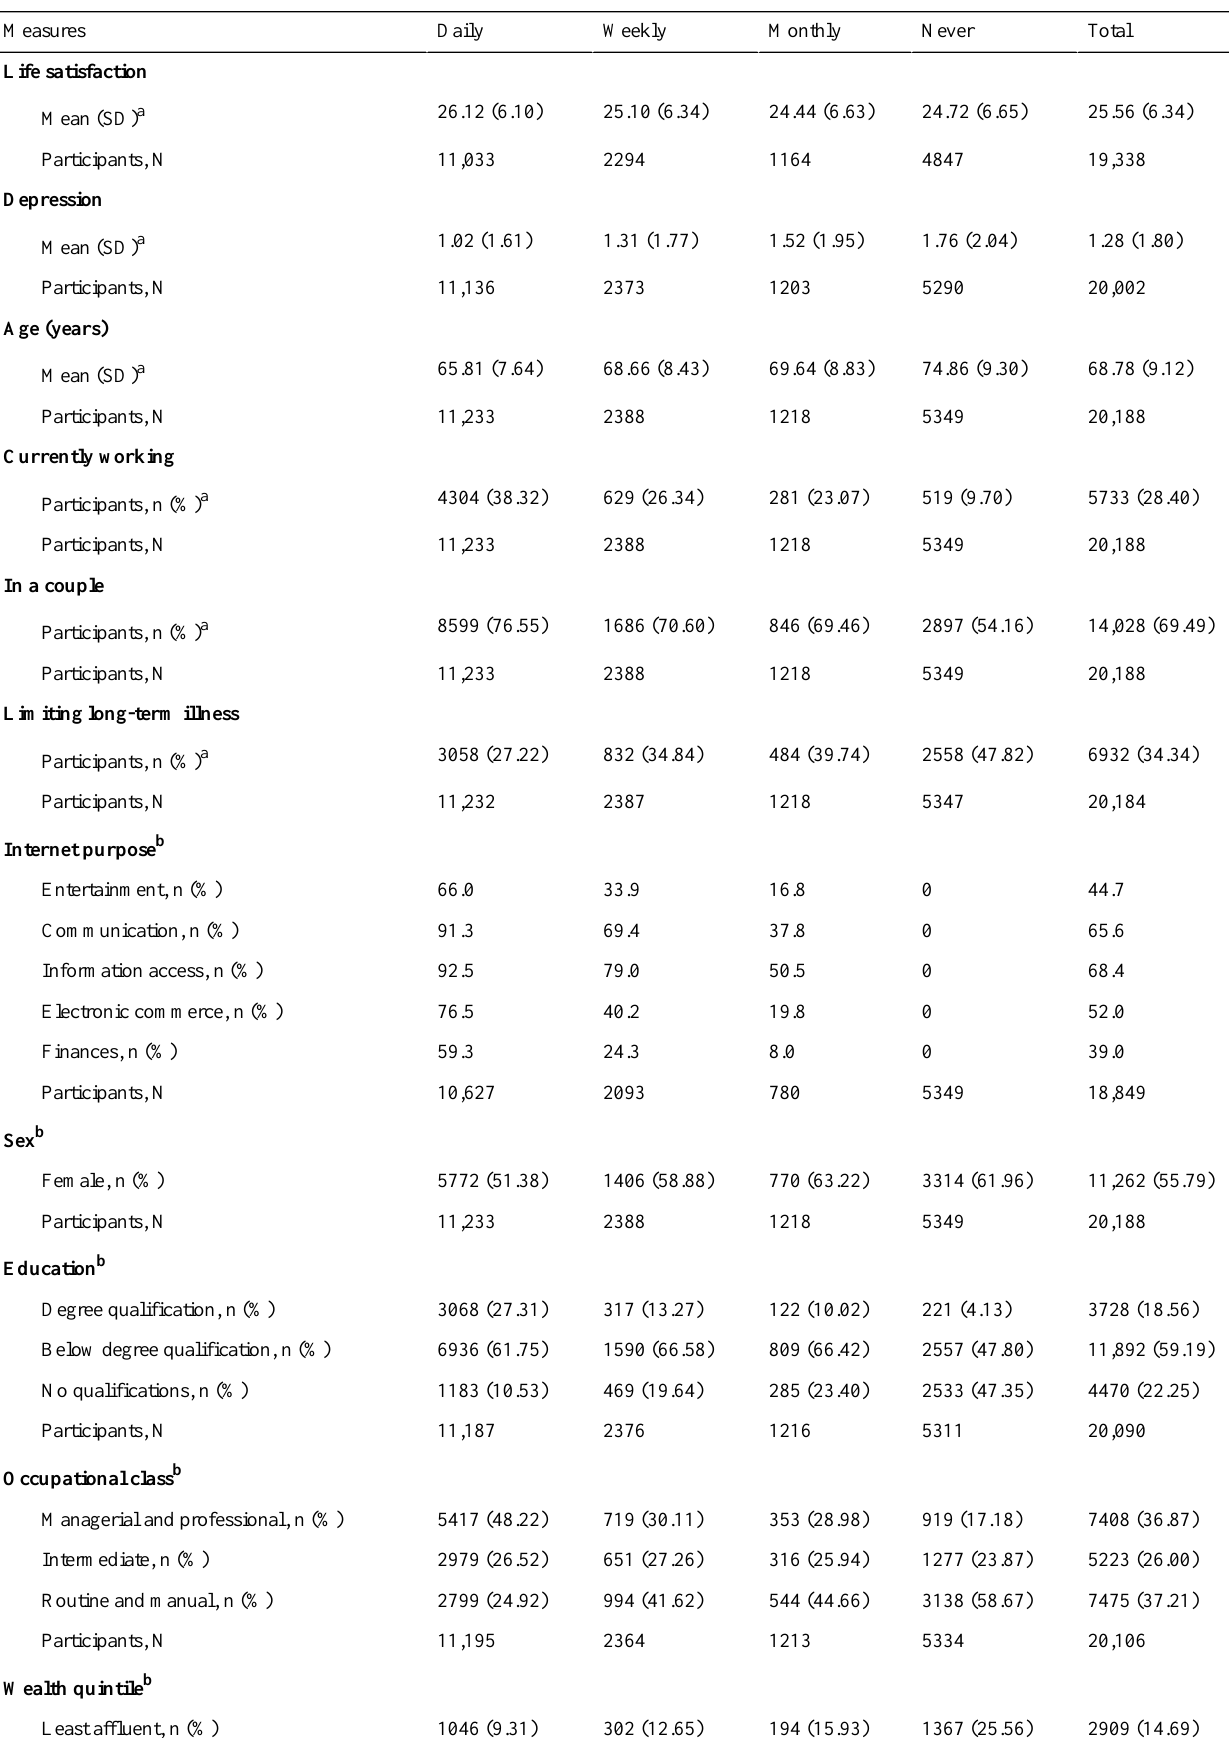
Table 1. Participant characteristics across person-waves by frequency of internet use (data are unweighted).